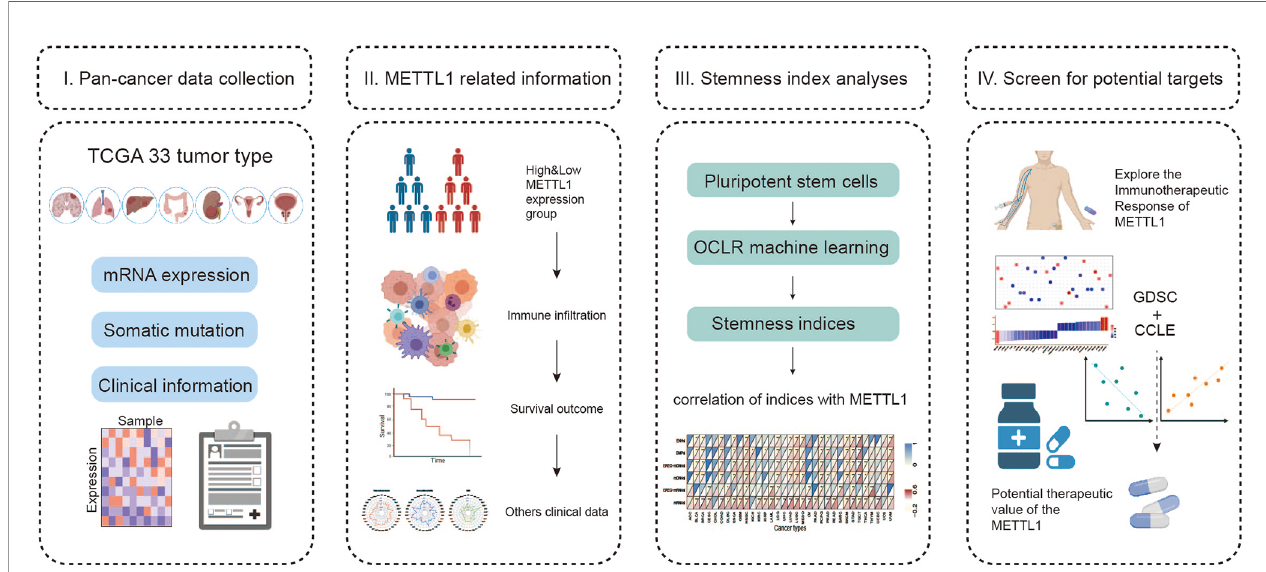
FIGURE 1 | Landscape of this study work fl ow. I. The mRNA expression data, somatic information and clinical traits were collected for follow-up analysis. II. Patients were divided into high and low expression groups according to METTL1 expression, and then we compared the immune in fi ltration, tumor mutation burden, survival prognosis, etc. between the different groups. III. Stemness indices were generated using OCLR algorithm and correlation analysis between stemness indices and METTL1 expression was performed. IV. Exploring the immunotherapeutic response of METTL1 in diverse ICB cohorts and investigating the potential targeting therapeutic value of